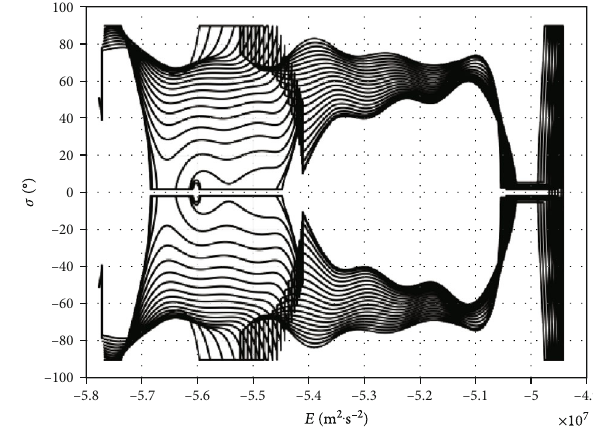
Figure 17: Altitude pro fi les for Case 1.